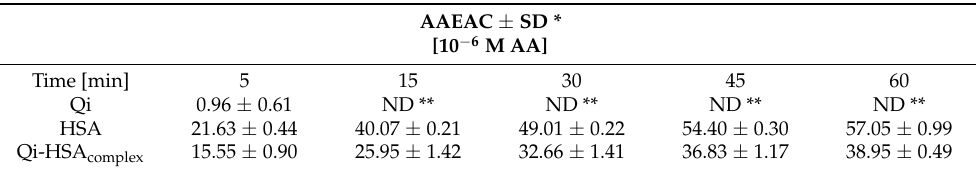
Table 6. The total AAEAC antioxidant capacity (ABTS assay); pH = 7.4).